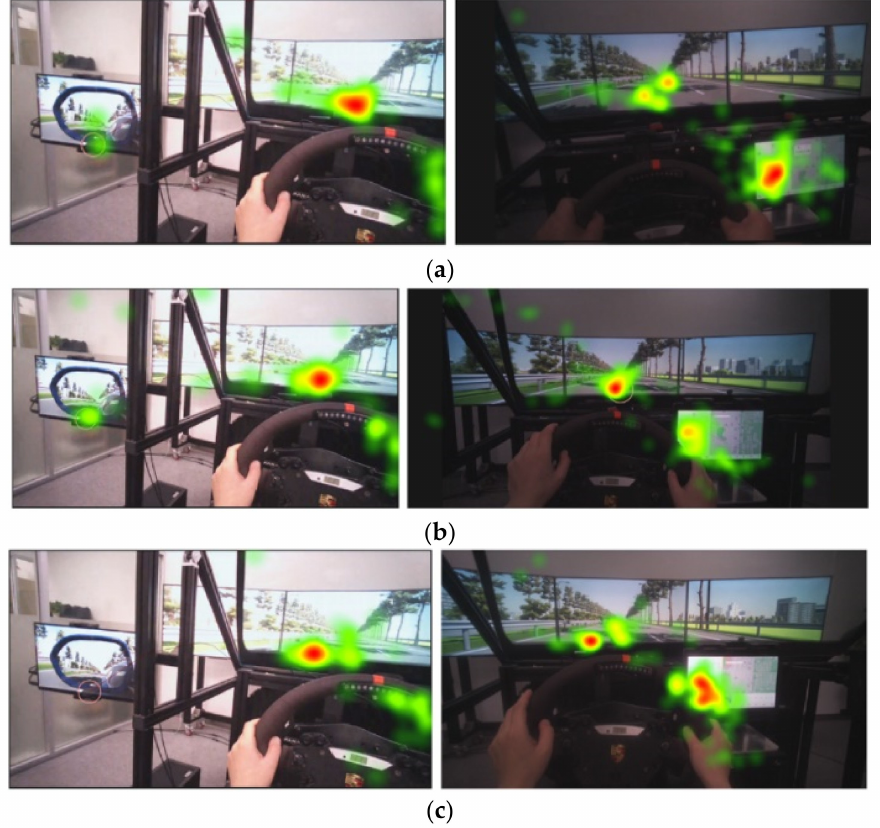
Figure 7. Superimposed schematic diagram of the subject’s eye-movement heat zone: ( a ) Scheme 1; ( b ) Scheme 2; ( c ) Scheme